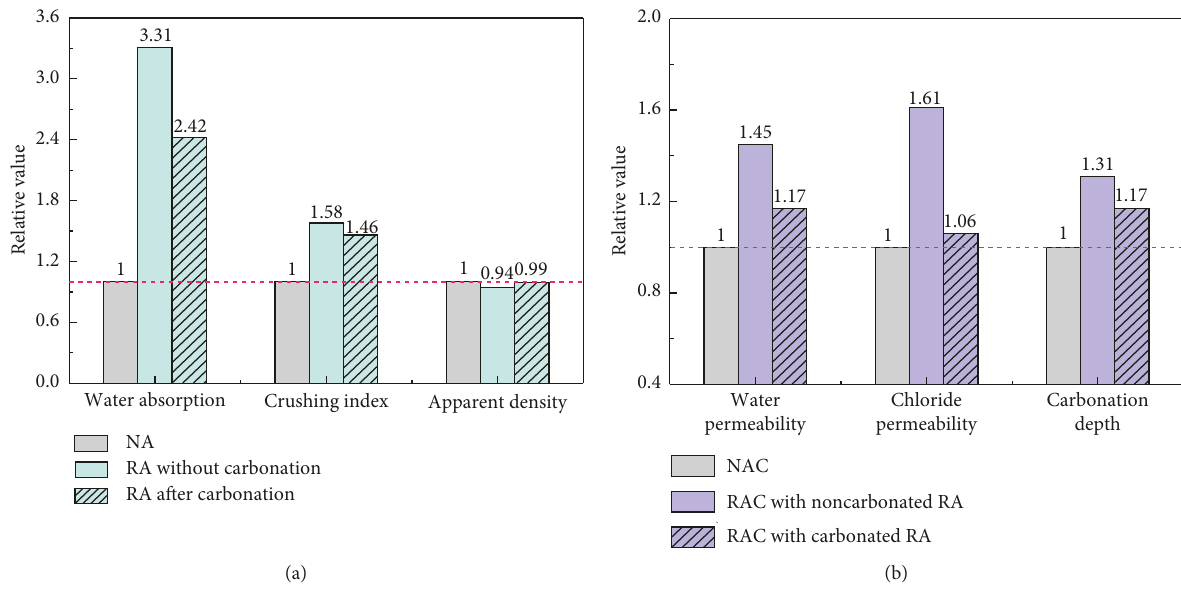
Figure 15: Durability properties of concrete with RA after carbonation modification [184]. (a) Characteristics of RA after carbonation and (b) durability properties of RAC.